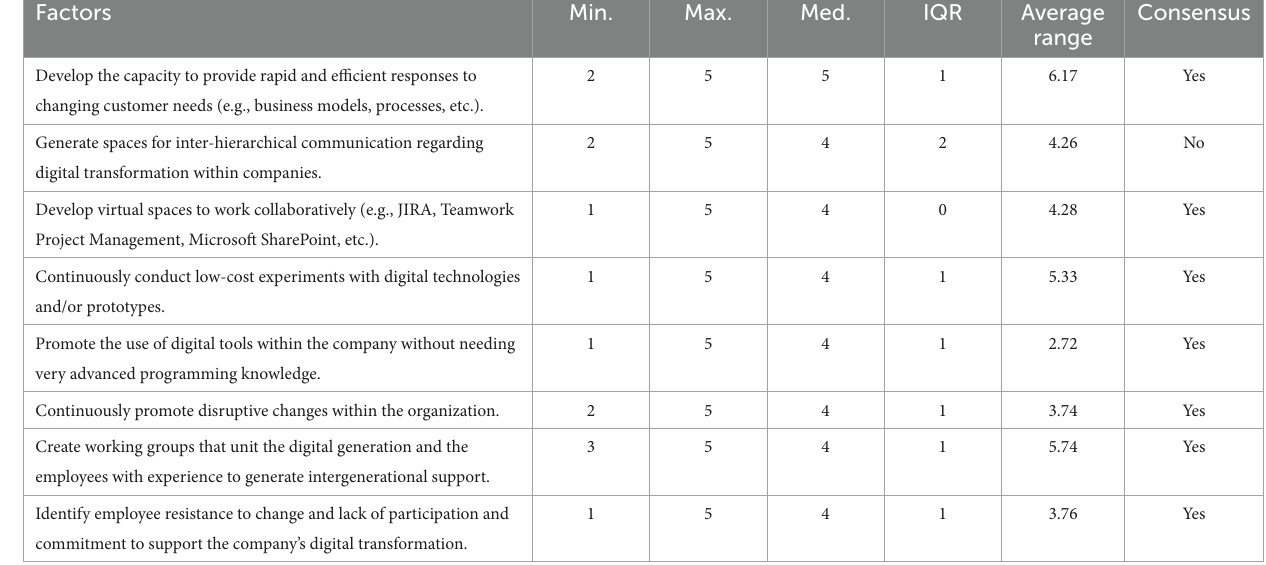
TABLE 6 Results from the third